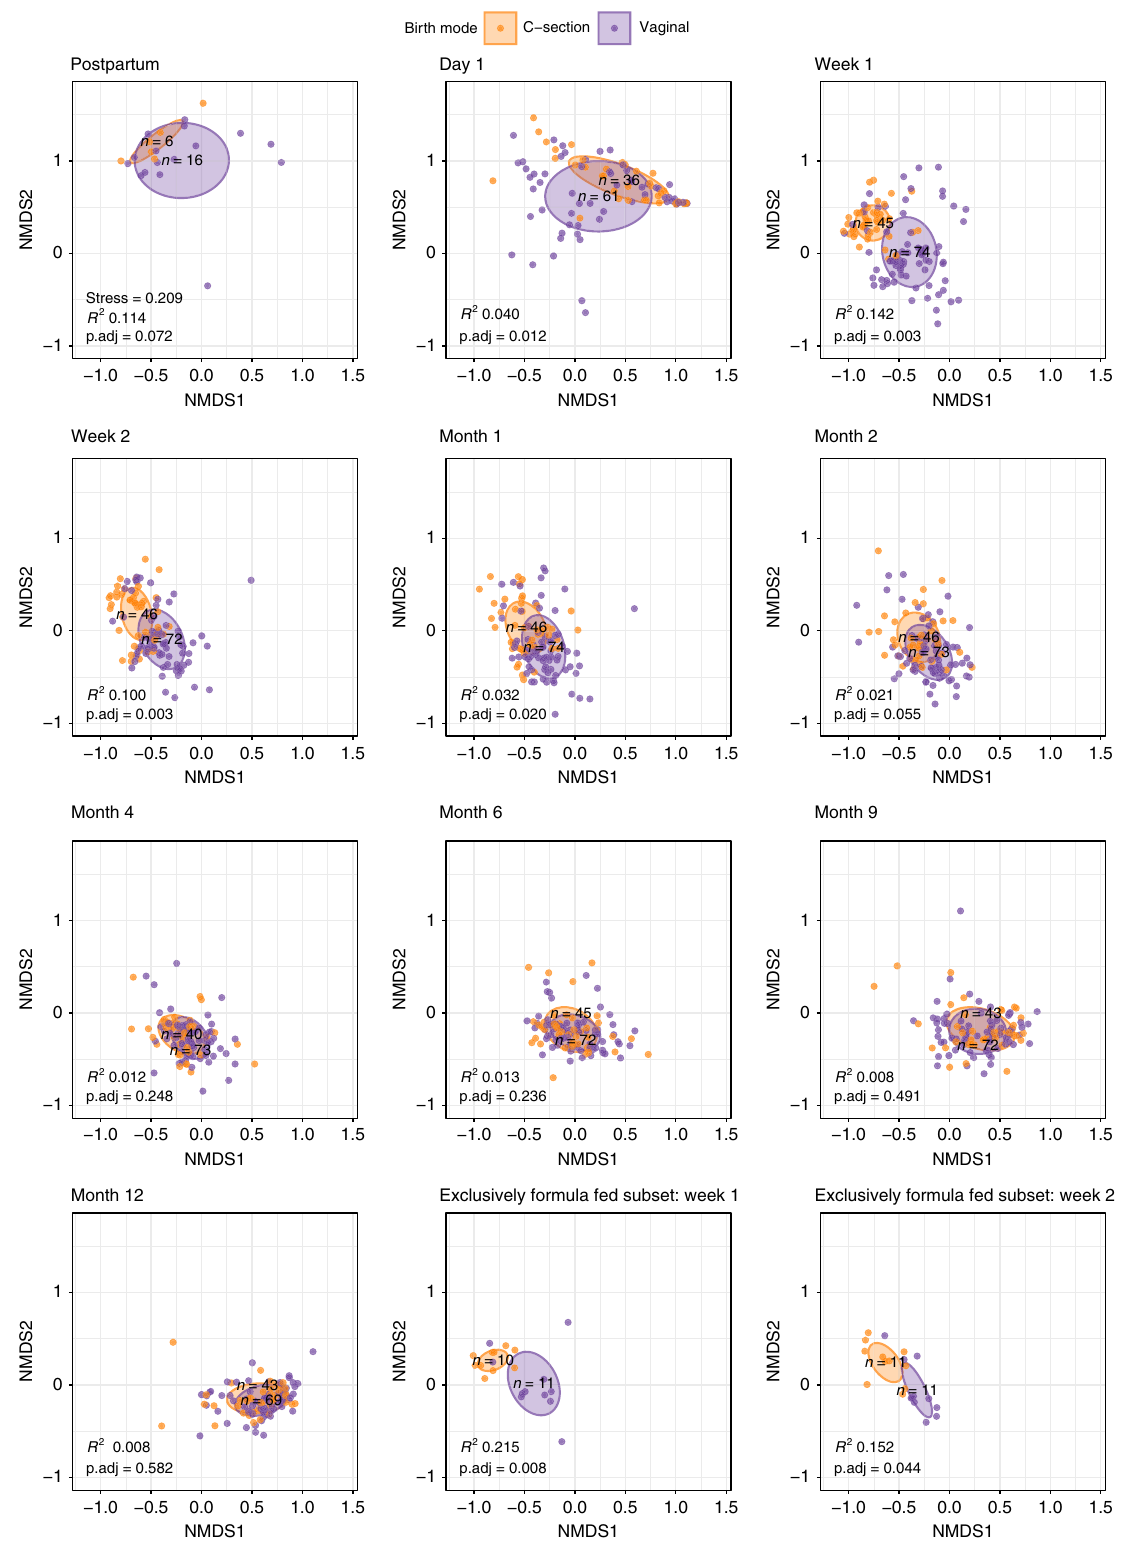
Fig. 2 NMDS plots of children ’ s samples per timepoint strati fi ed according to mode of delivery. Nonmetric multidimensional scaling (nMDS) plots, based on Bray – Curtis (BC) dissimilarity between samples, visualizing the overall gut bacterial community composition strati fi ed for mode of delivery, per timepoint. Each data point represents the microbial community composition of one sample. The ellipses represent the standard deviation of data points belonging to each birth mode group, with the center points of the ellipses calculated using the mean of the coordinates per group. The stress of the ordination, effect sizes ( R 2 ) calculated by multivariate permutational multivariate analysis of variance (PERMANOVA) tests and corresponding adjusted p - values (p.adj) are shown in the plots, and n represents the biologically independent samples per